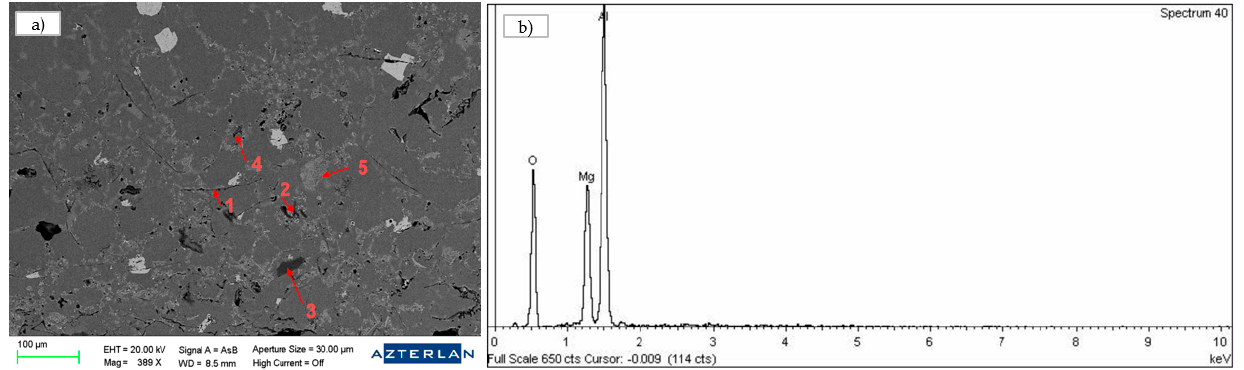
Figure 6. The inclusion cakes used for the different alloys: ( a ) before and ( b ) after the melt treatment for the primary alloy sample; ( c ) before and ( d ) after the melt treatment for the secondary alloy sample made from ingots; ( e ) before and ( f ) after the melt treatment for the secondary alloy sample made from new scrap. Table 5. Thicknesses of the inclusion cakes.